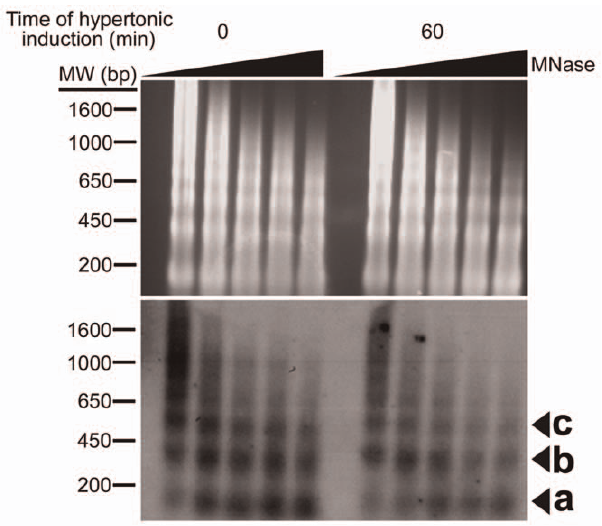
Figure 3. Increased MNase accessibility at the ORE region after hypertonic induction. (upper) Nuclei were prepared from cells that were induced with hypertonic stress for 0 and 60 min respectively, and chromatin was subjected to limited digestion with MNase increasing times. The nucleosome ladder was resolved in agarose gel and visualized by ethidium bromide staining; (lower), the DNA was subjected to Southern blots analysis using a 32 P-labeled probe spanning the ORE (ORE MNase , Fig. 1A). The triangles denote increasing times of MNase digestion. a, mononucleosome; b, dinucleosomes; c,